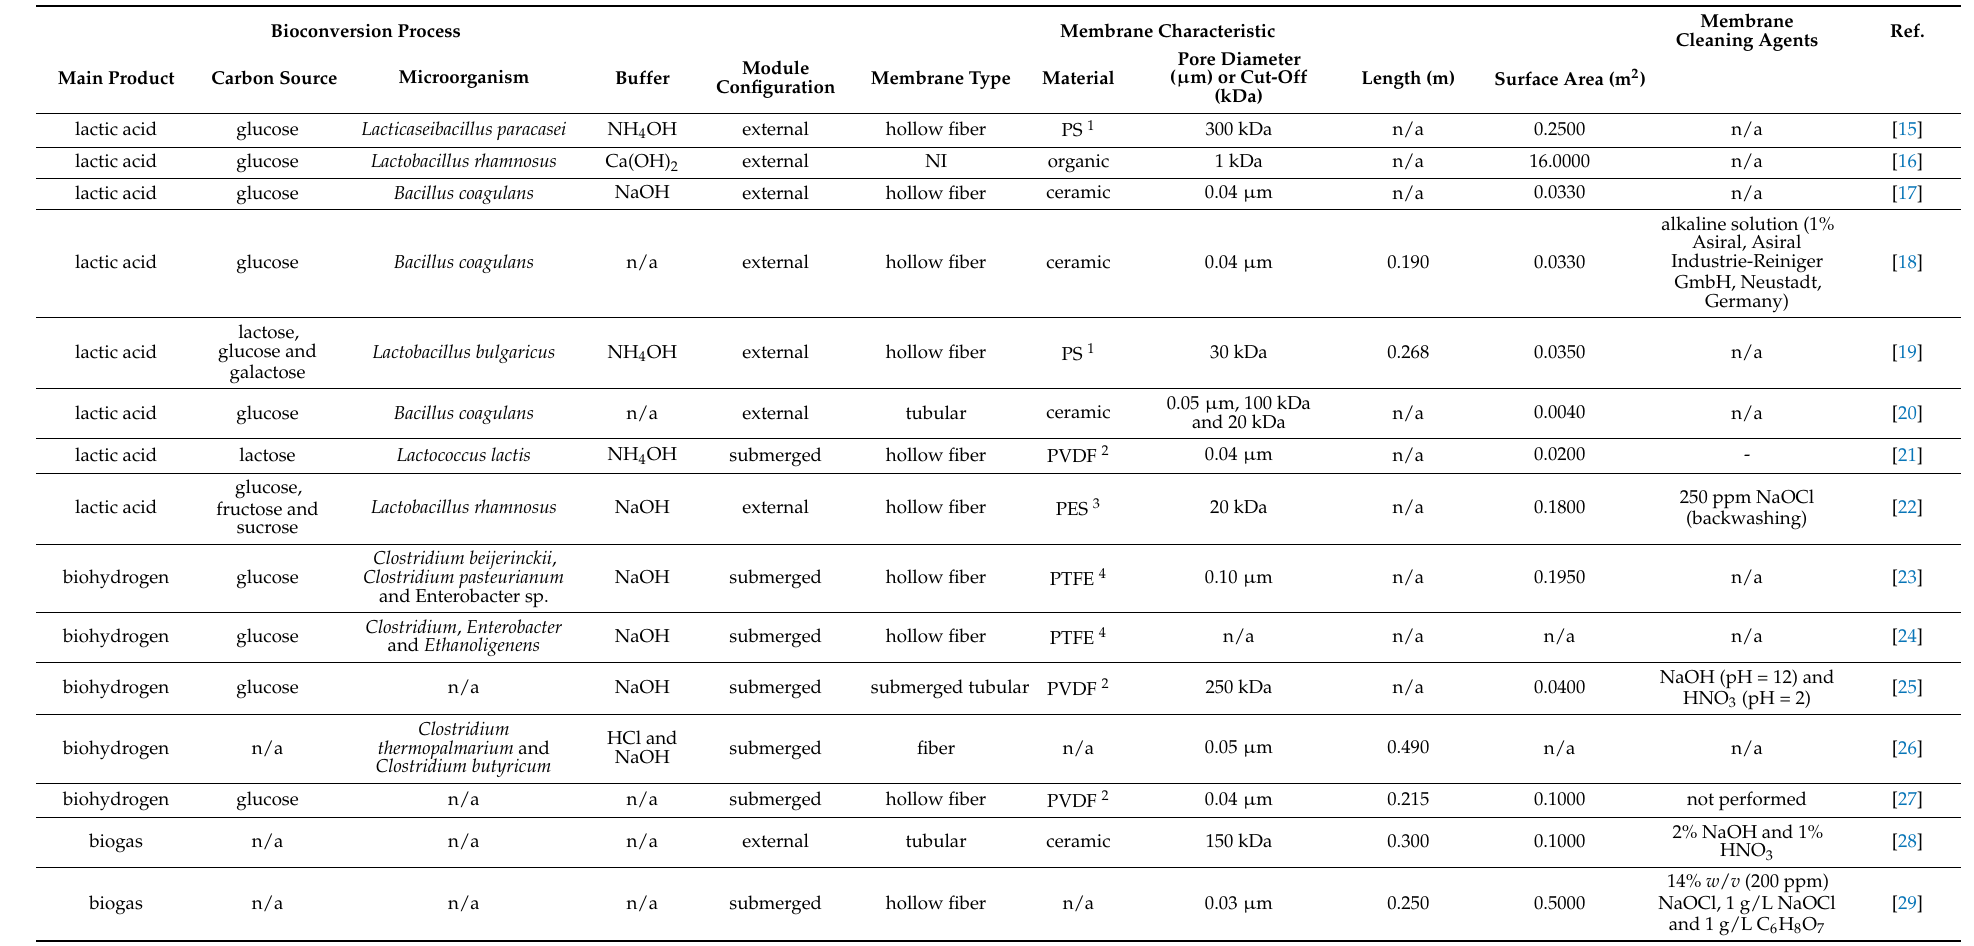
Table A1. Application of UF membranes in MBR technology: literature